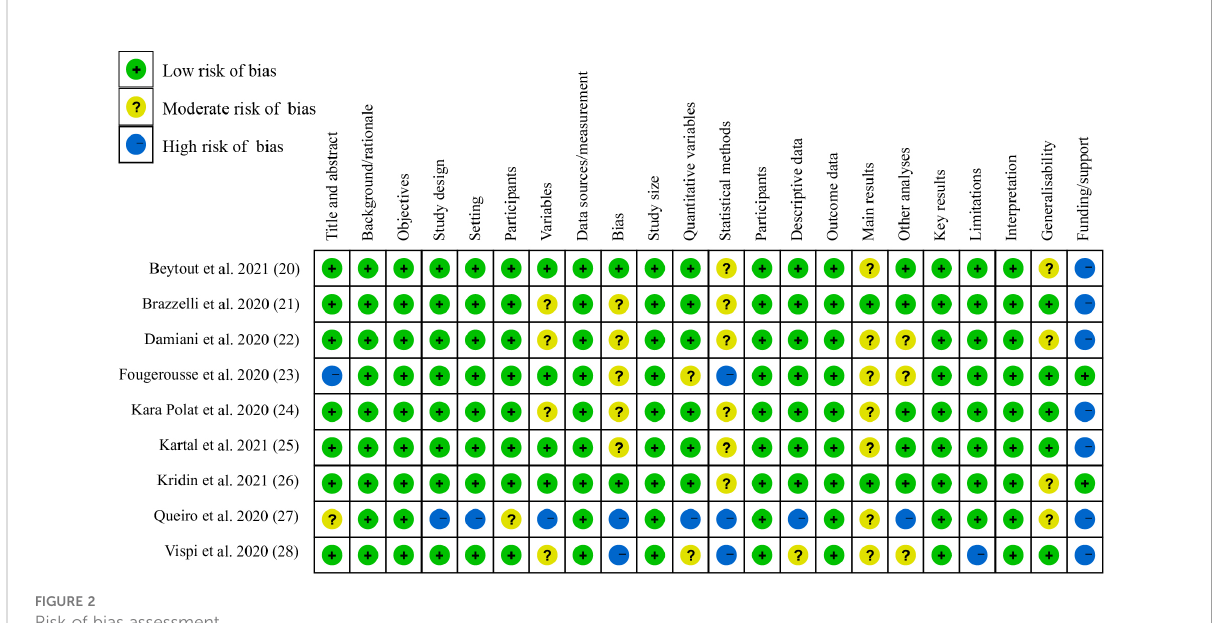
FIGURE 2 Risk of bias